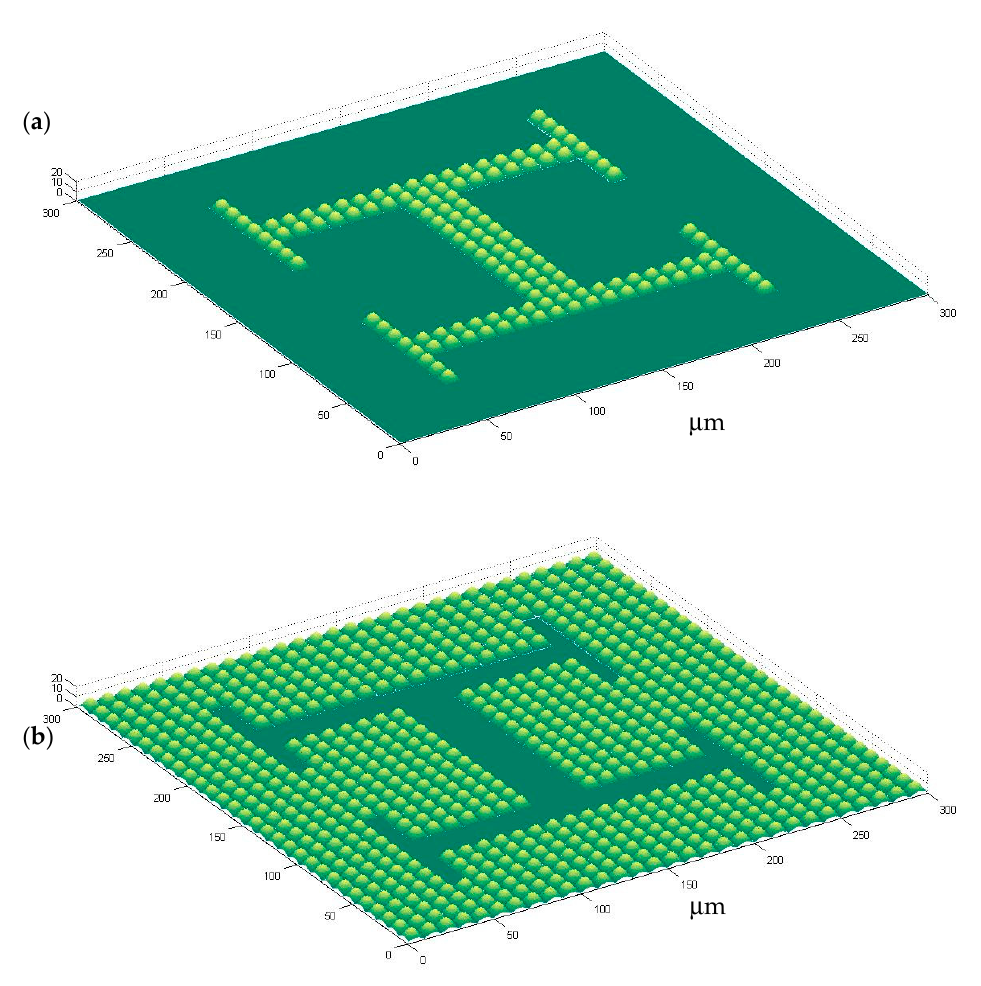
Figure 1. Computer-aided design of microstructured surfaces showing both positive and negative alternatives: ( a ) Microtextured vascular-like region upon a plane; ( b ) planar vascular-like region surrounded by microtexture. Scale in micrometers.